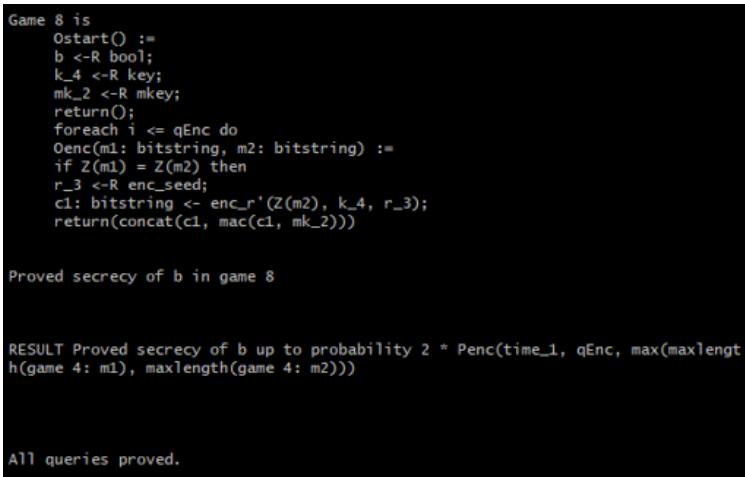
Figure 10. First Game of Verifying the IND-CPA Property of Platoon Key Update Phases.